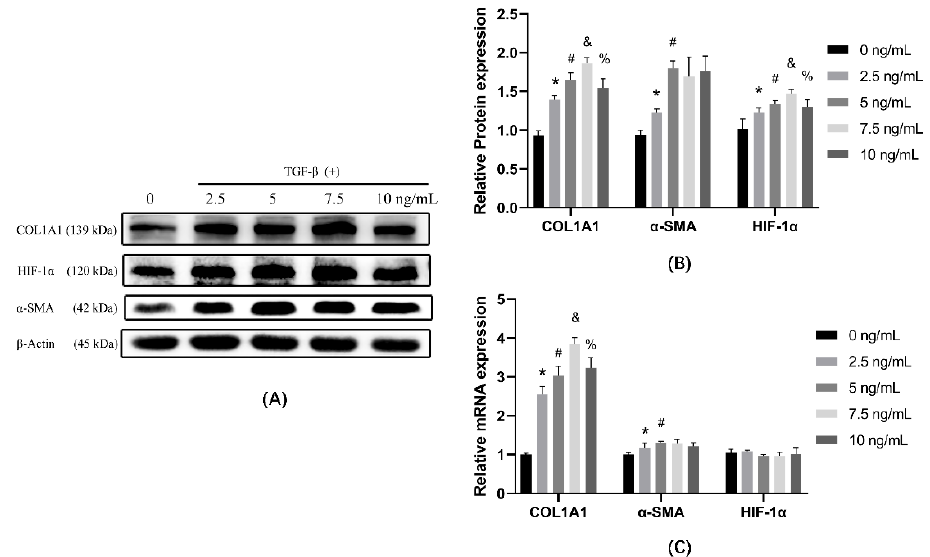
Figure 1. The effect of TGF- β 1 on cell transdifferentiation was analyzed by comparing the expression of COL1A1, HIF-1 α , and α -SMA using TGF- β 1-treated cells at different concentrations. ( A ) Western blot analysis of col1a1, HIF-1 α , and α -SMA in cells of different groups. β -actin was used as loading control. ( B ) Quantitative analysis of COL1A1, HIF-1 α , and α -SMA is shown in Figure 1A. ( C ) Cells were treated with TGF- β 1 at different concentrations, and mRNA was extracted from the treated groups. mRNA expression was determined by qPCR and normalized to β -actin. * p < 0.05 vs. 0 ng/mL group; # p < 0.05 vs. 2.5 ng/mL group; & p < 0.05 vs. 5 ng/mL group; % p < 0.05 vs. 7.5 ng/mL group. Results are expressed as means ± SD. ANOVA was used to compare multiple groups and pairwise comparisons were compared by LSD-t test. A value of p < 0.05 was considered to be statistically significant .